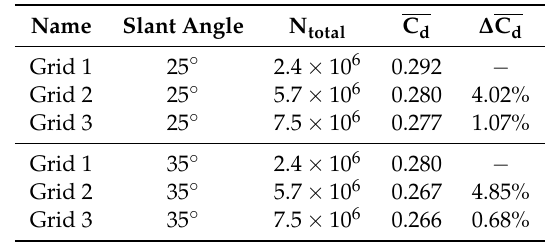
Table 1. Comparison of drag coefficients based on different spatial grid distributions at Re = 7.68 × 10 5 .